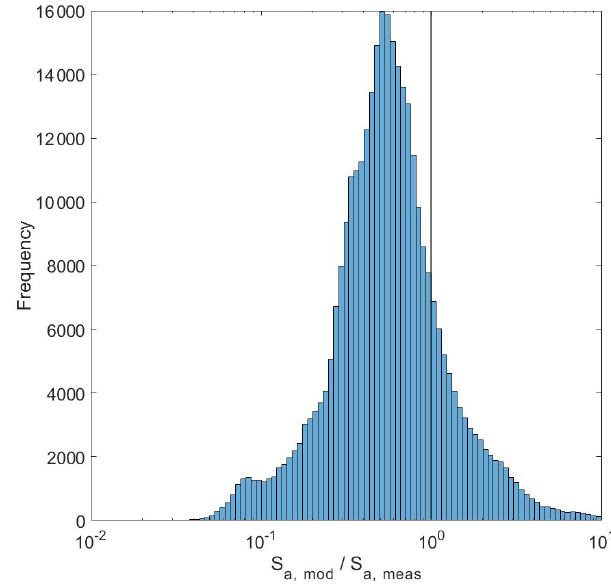
Figure 7. Histogram of the ratio of modeled-to-measured aerosol surface area concentration ( S a , mod /S a , meas ) over the full DISCOVER-AQ